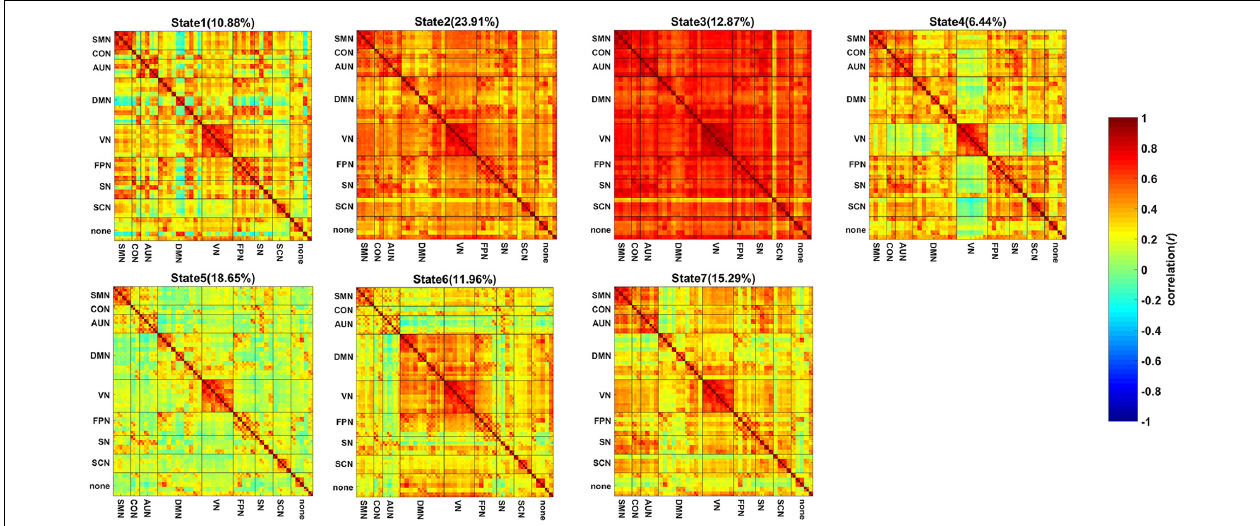
FIGURE 1 | The centroid pattern of 7 FC states clustered by K-means. The percentage of occurrences is listed above each FC pattern. The FC pattern of each state represents Pearson correlation between each pair of brain regions.